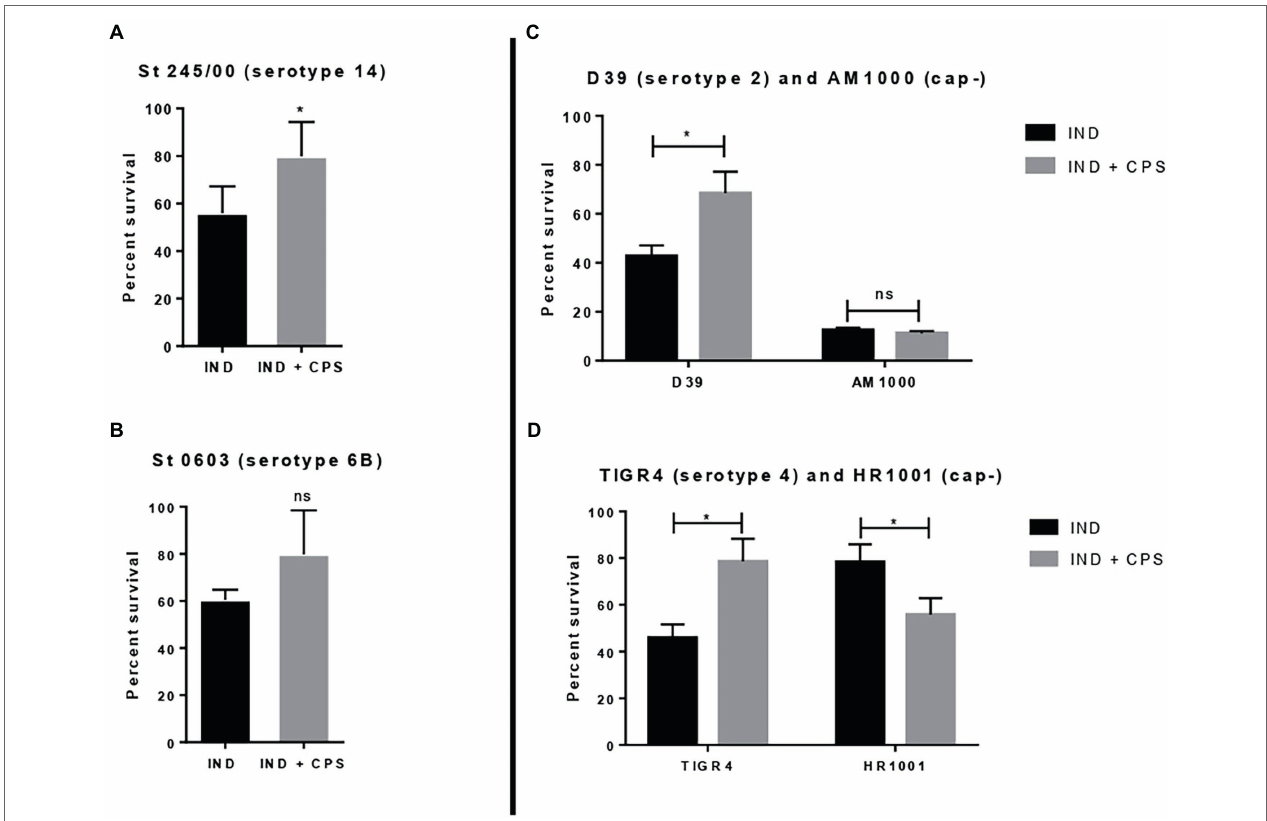
FIGURE 4 | Effect of free capsular polysaccharide on the lytic action of indolicidin. Peumococcal strains St 245/00 (A) , St 0603, serotype 6B (B) , D39, serotype 2 and its capsule-negative mutant (C), and TIGR4 and its capsule-negative mutant (D) were treated with indolicidin preincubated with purified CPS 6B. Each bar represents the percent in survival relative to the control group. Statistical analysis was performed using Student’s t -test. * p < 0.05 in comparison with indolicidin treatment in absence of CPS. ns, not significant.